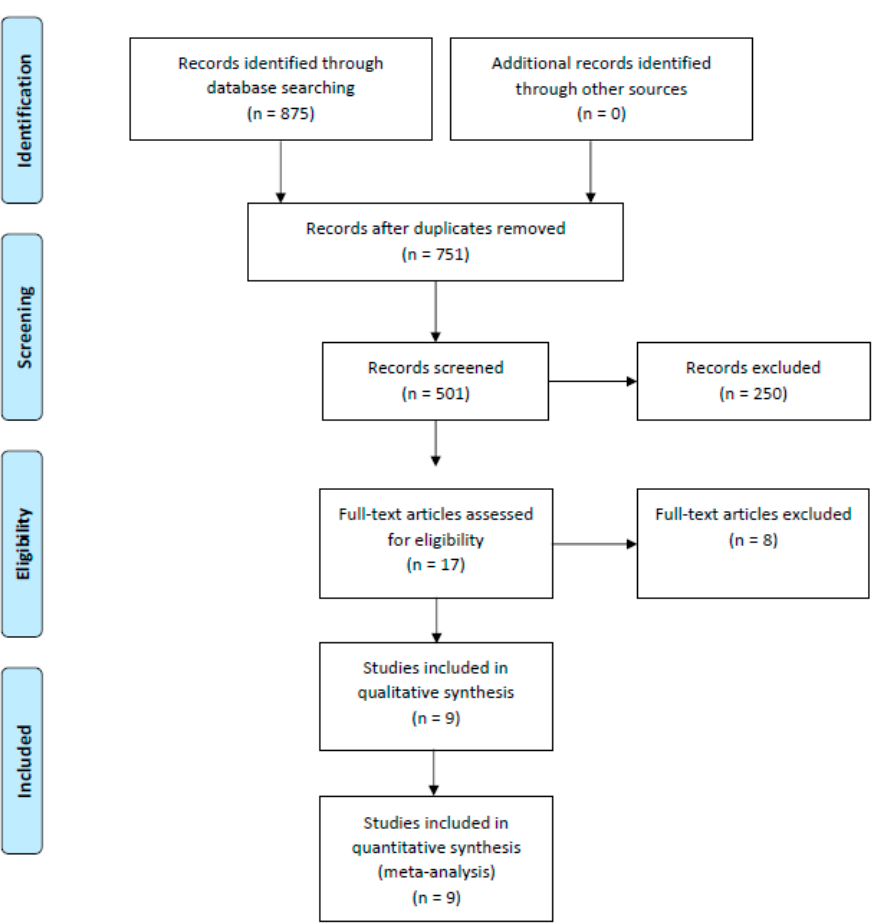
Figure 1. PRISMA flow diagram for systematic literature review process.